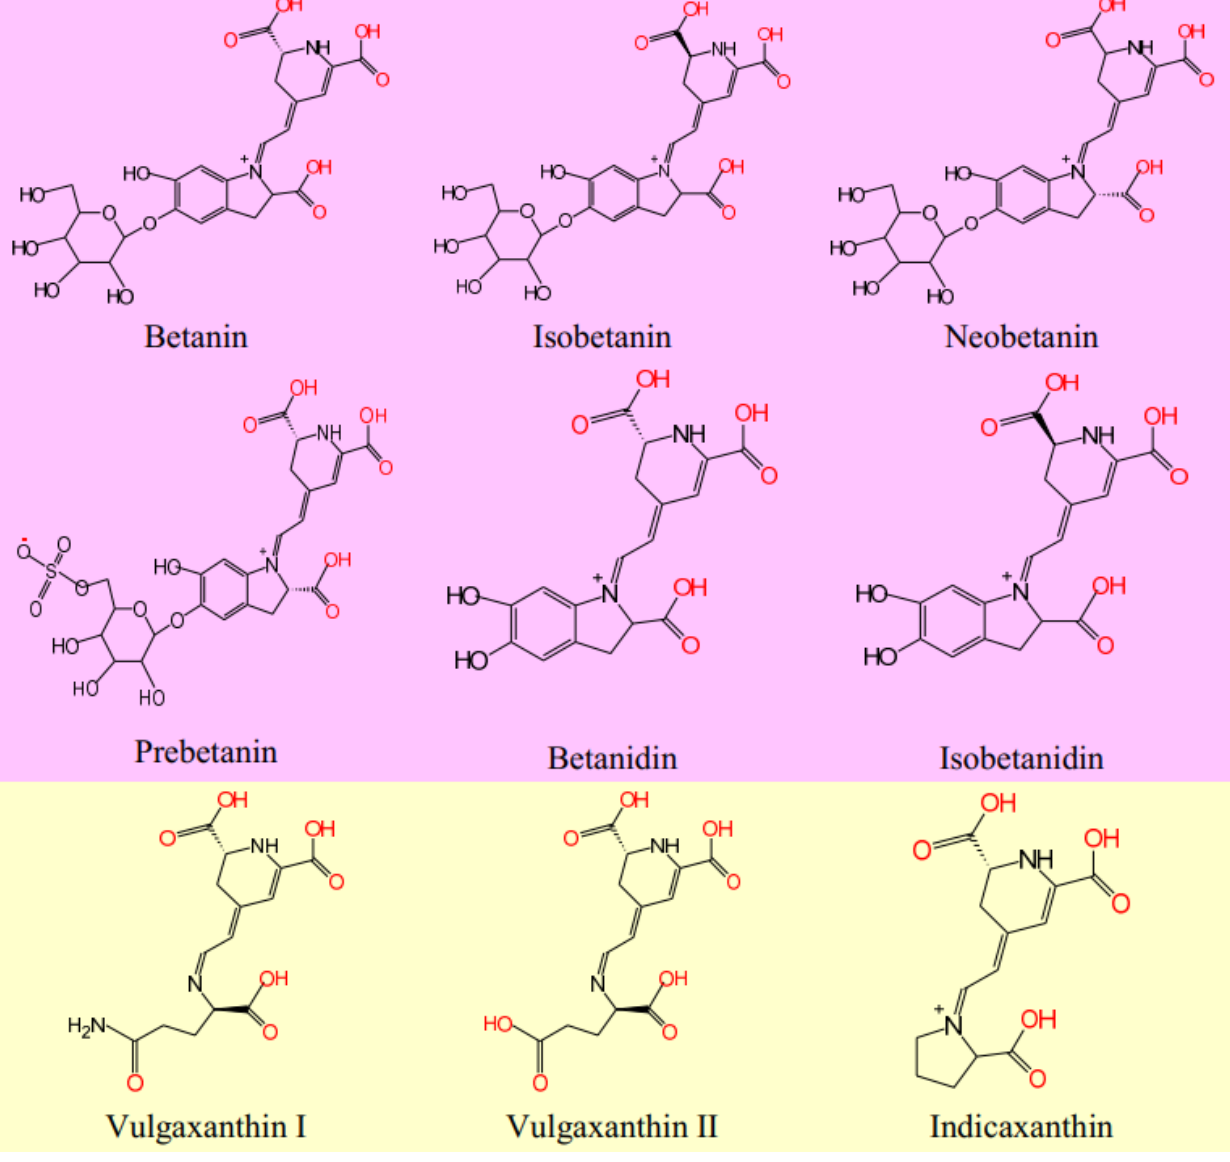
Figure 7. Chemical structure of the main components of betalains: betacyanins and bethaxanthin.